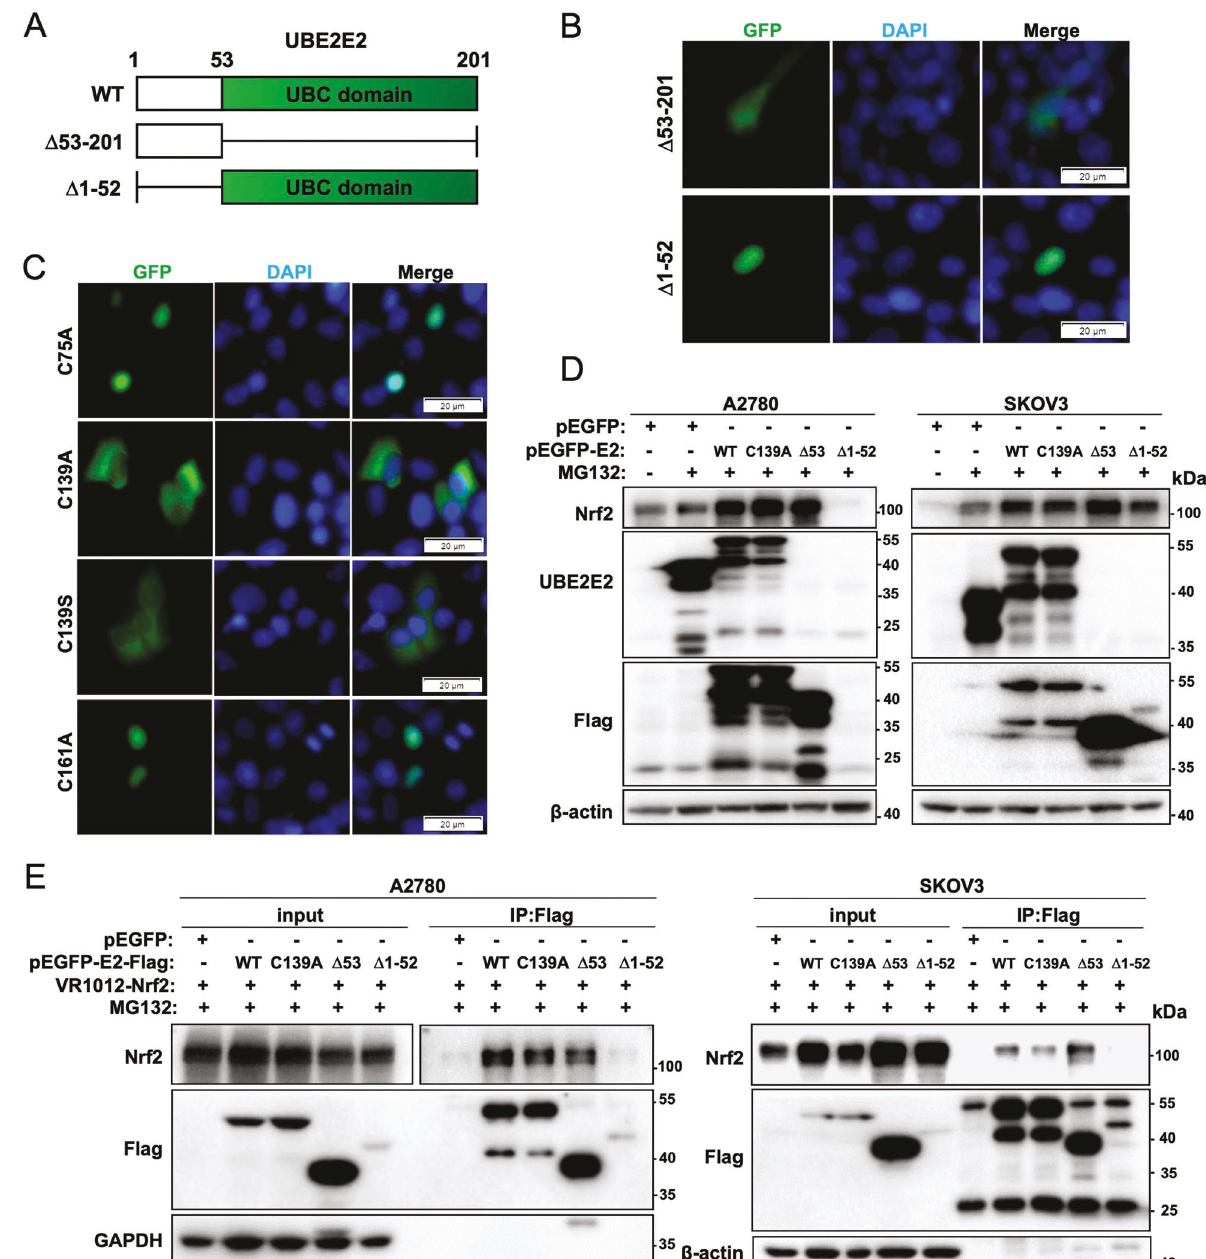
Fig. 6 The N-terminal of UBE2E2 is required for its interaction with Nrf2. A Schematic diagram showing the full-length and truncated forms of UBE2E2. The numbers indicate the positions of the amino acids. WT wild-type. B Effects of the truncation mutation on the UBE2E2 intracellular distribution. An overlay of blue (nuclei) and green (GFP) channels is shown. Scale bar = 20 μ m. C Effects of mutations on the UBE2E2 intracellular distribution in SKOV3 cells. An overlay of blue (nuclei) and green (GFP) channels is shown (scale bar = 20 μ m). D The expression of Nrf2, Flag and UBE2E2 was explored by western blot analysis 72 h after transfection with WT or mutant UBE2E2 expression vectors. MG132 was added to the cultures 12 h prior to cell harvesting. β -actin was used as the loading control. Δ 53 Δ 53-201. E Immunoprecipitation (IP) of Flag-tagged WT or mutant UBE2E2 in OvCa UBE2E1, and UBE2E2, bind to recombinant H6-S-Nrf2 in the p62 induced by UBE2E2, and the data do not rule out the presence of N -ethylmaleimide (NEM) [29]. Here, we demonstrated possibility of weak or transient interactions between the proteins. that the overexpression of UBE2E2 upregulated the expression The antioxidant capacity of OvCa plays a crucial role in cell levels of Nrf2 and its target genes, whereas the Nrf2 activator survival and metastasis, and Nrf2 is the major regulator of the tBHQ failed to stimulate the Nrf2 pathway in UBE2E2-depleted endogenous antioxidant defense system [28]. As mentioned cells. Moreover, UBE2E2-de fi cient OvCa cells exhibited impairment above, p62 contributes to the activation of the Nrf2 signaling of forming clones in vitro and growing into tumors in vivo, which pathway by creating a positive feedback loop. In addition, Plafker may have been partially due to a lowered antioxidant capacity. et al. reported that three class III E2 proteins, UbcM2, UbcM3/